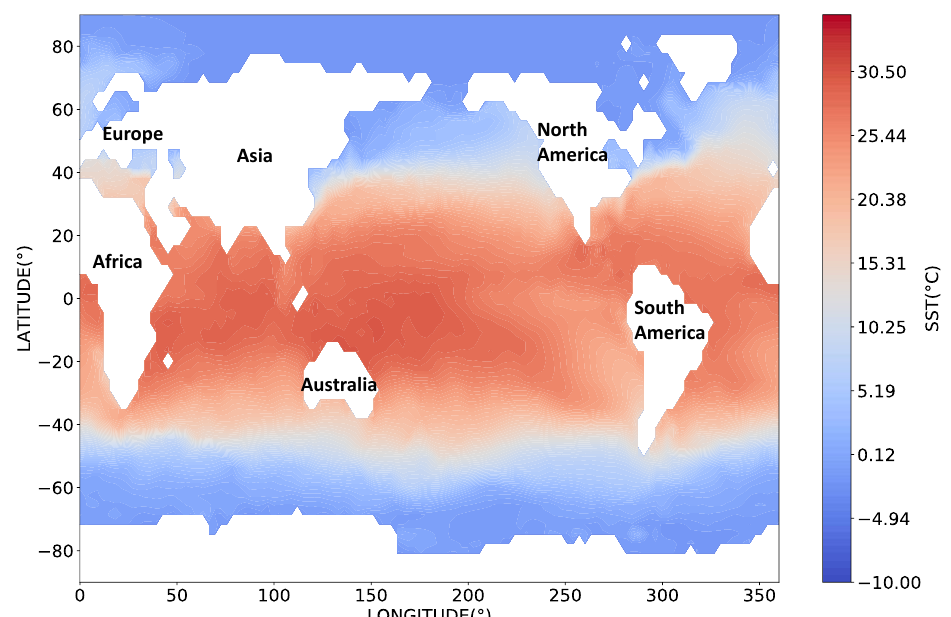
Figure 1. The global monthly average SST in January 2002, where the white areas are land, the darker red color represents the higher temperature, and the darker blue color represents the lower temperature.